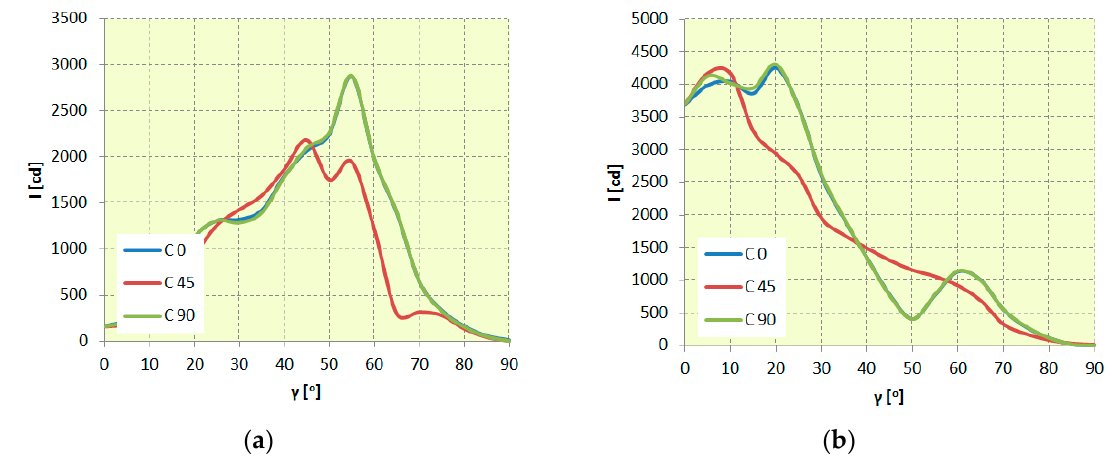
Figure 14. Luminous intensity curves for a luminaire with a mirror reflector: ( a ) wide distribution ( b ) narrow distribution.